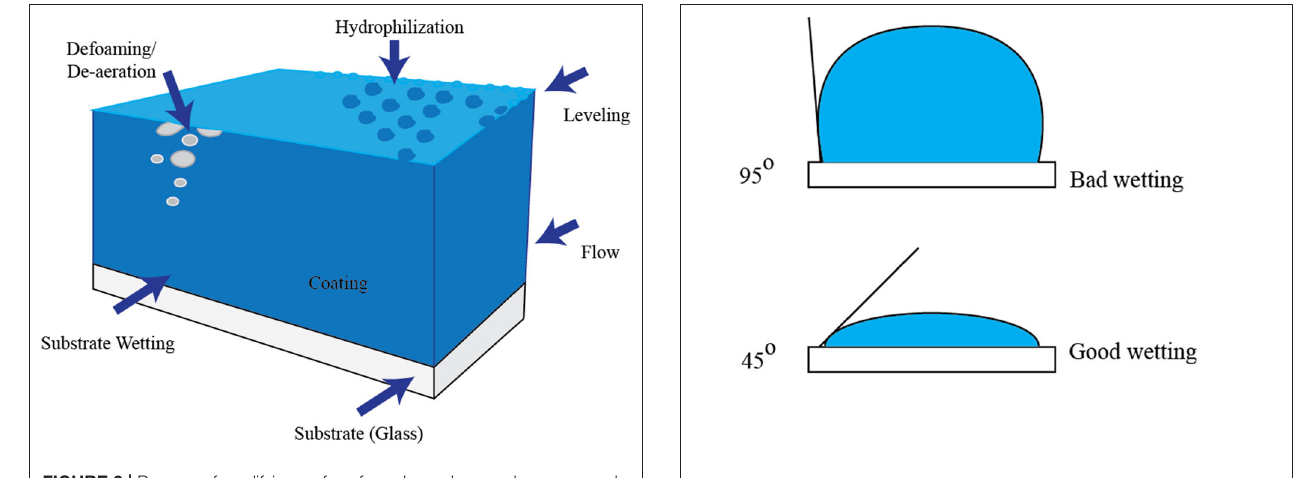
FIGURE 2 | Process of modifying surface for polar and non-polar compound groups.